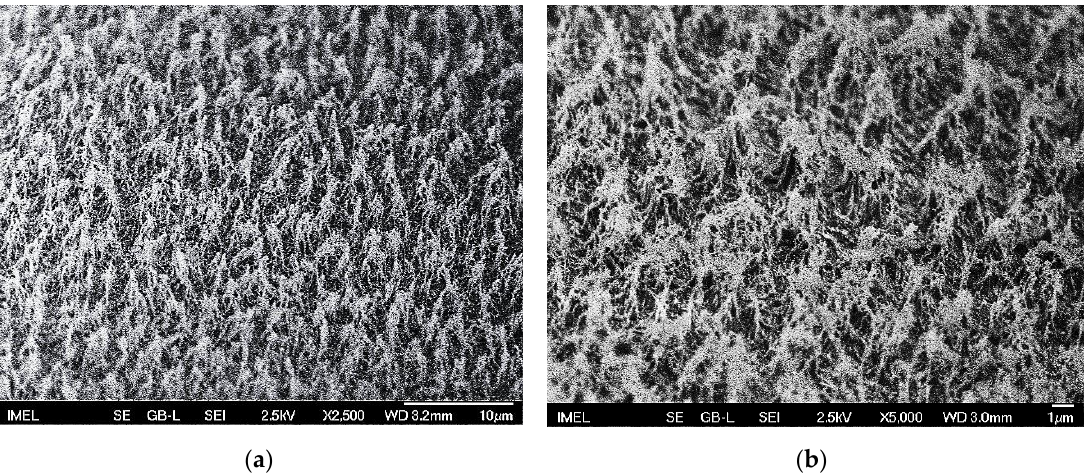
Figure 1. Scanning electron microscopy (SEM) images of micro-nanotextured poly(methyl methacrylate)/PMMA surfaces after 10 min highly anisotropic oxygen (O 2 ) plasma treatment at ( a ) ×2500 magnification and ( b ) ×5000 magnification for better visualization of the induced nanotopography. The induced micro-nanoroughness is accompanied by chemical modification of the PMMA surfaces, with the introduction of carbonyl (C=O), carbonate (O 2 –C=O) and O–C–O chemical